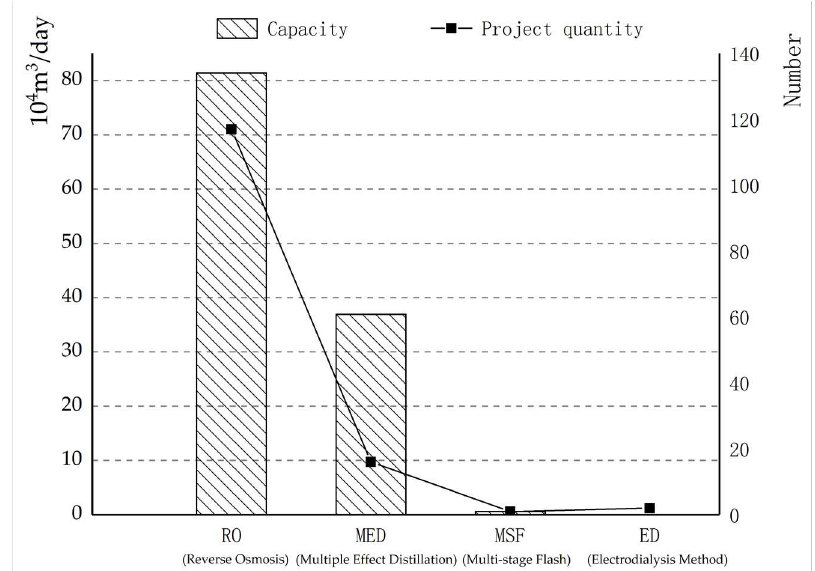
Figure 6. The distribution structure of utilization type of desalination technology by the end of 2017.